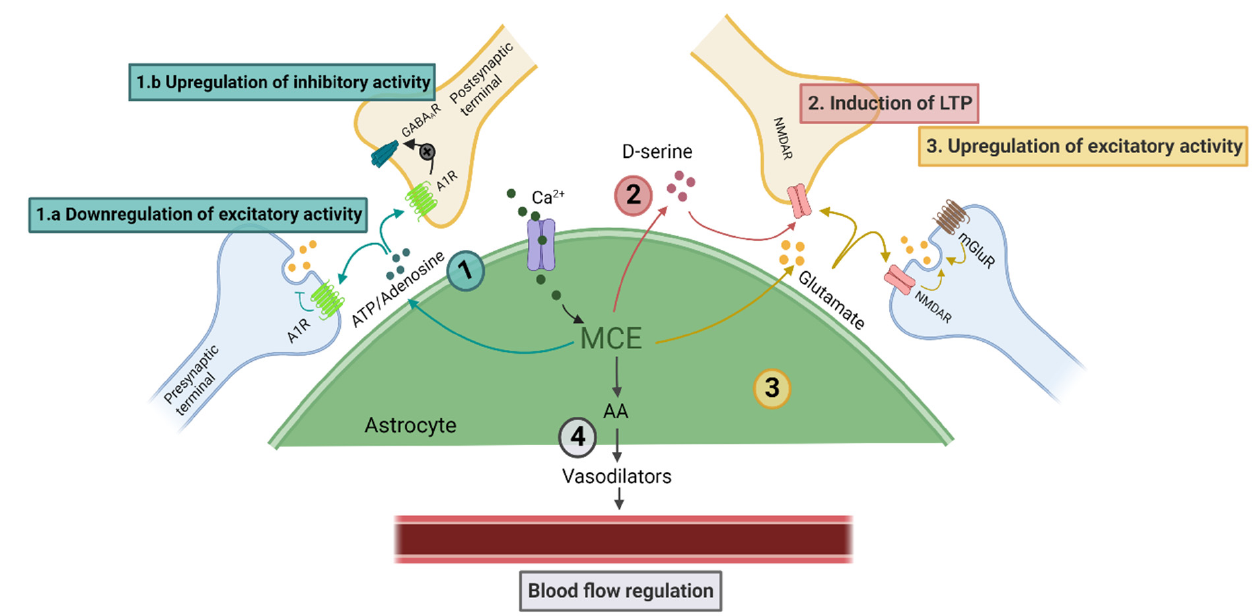
Figure 1 . Examples of functional roles of astrocyte Ca 2+ events. MCEs lead to gliotransmission: (1) ATP/adenosine a. downregulates the excitatory activity by activating presynaptic A1R [60] and b. upregulates inhibitory activity by activating postsynaptic A1R [40]. (2) D-serine enhances LTP via postsynaptic NMDARs [41]. (3) Glutamate released from astrocytes modulates pre- and post-synaptic neuronal glutamate receptors [36,50,56,57,59,61]. (4) In astrocyte endfeet, MCEs cause the production of arachidonic acid (AA) that is metabolized to vasodilative components, such as prostaglandins, and contribute to regulation of cerebral blood flow [12].